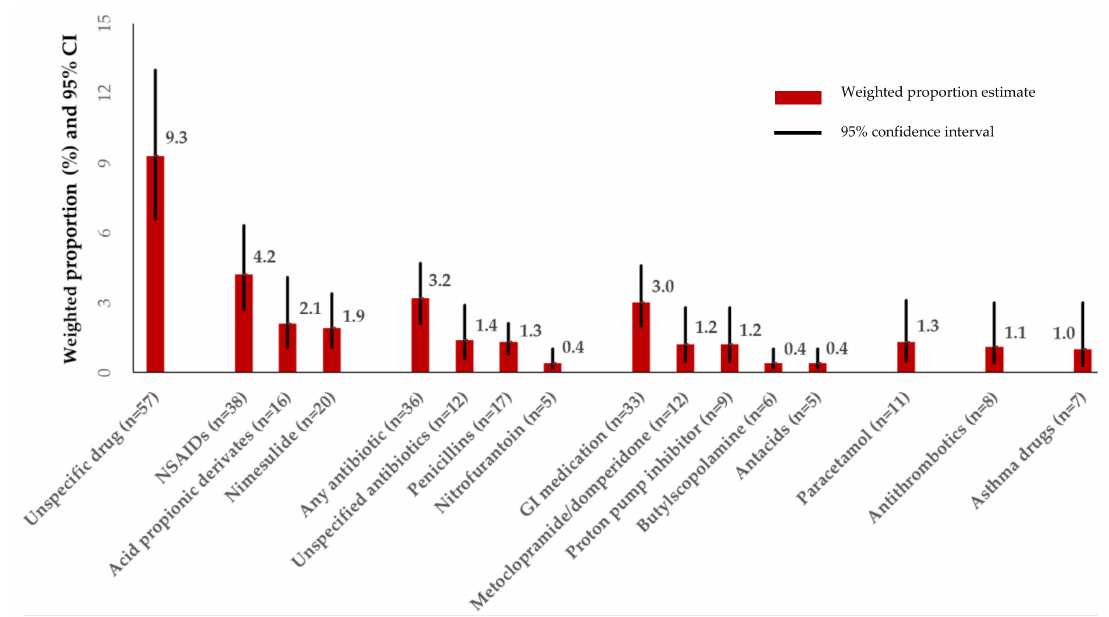
Figure 1. Most common medications intentionally avoided in pregnancy despite being prescribed ( n = 926) 1 . 1 Magnitude of proportions may not directly align with number of women in the various categories because proportions are weighted via survey weighting method. Abbreviations: 95% CI: 95% confidence interval; NSAID = Non-steroidal anti-inflammatory drugs; GI =